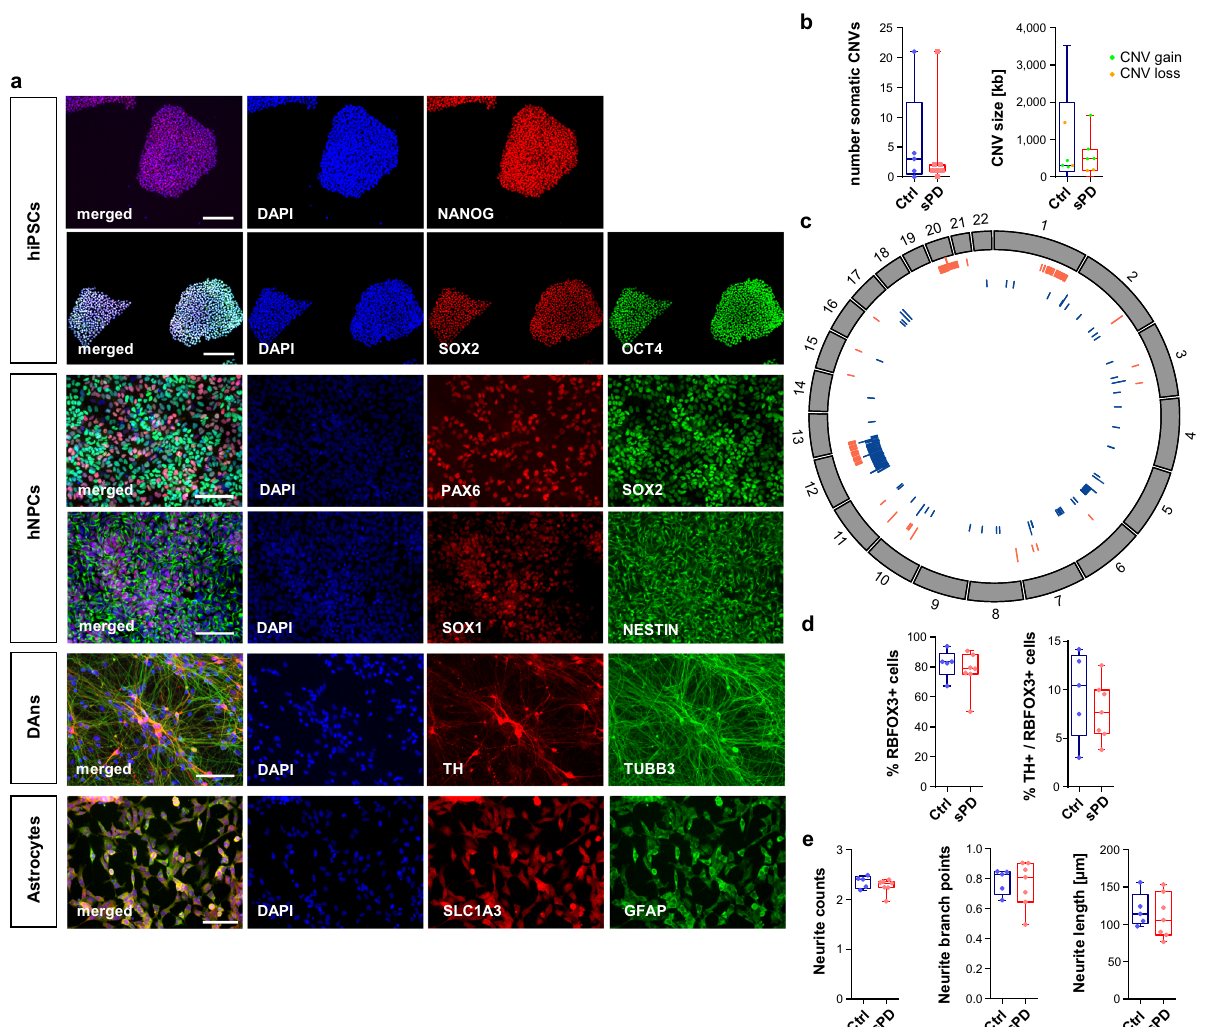
Fig. 1 | Characterization of hiPSC derived hNPCs, neurons and astrocytes. a Immunostainings exemplarily shown for O3H-R1-003. hiPSC pluripotency stain- ingformarkersOCT4,NANOG,SOX2.Scalebar=200 µ m.hNPCstainingformarkers SOX1,SOX2, NESTIN, PAX6.Scale bar=100 µ m. Neuronstaining formarkersTUBB3 and DAn marker TH. Scale bar=100 µ m. Astrocyte staining for markers GFAP and SLC1A3. Scale bar=100 µ m. b Summary of somatic CNVs identi fi ed in hNPC clones by chromosomal microarray analysis shown as total number of somatic CNVs detected per analyzed clone and average length of CNVs (in kb; green=copy number gain; orange=copy number loss) per analyzed clone. n =5 Ctrl and 7 sPD patients. c Circos plot showing the genomic distribution of somatic CNVs in Ctrl